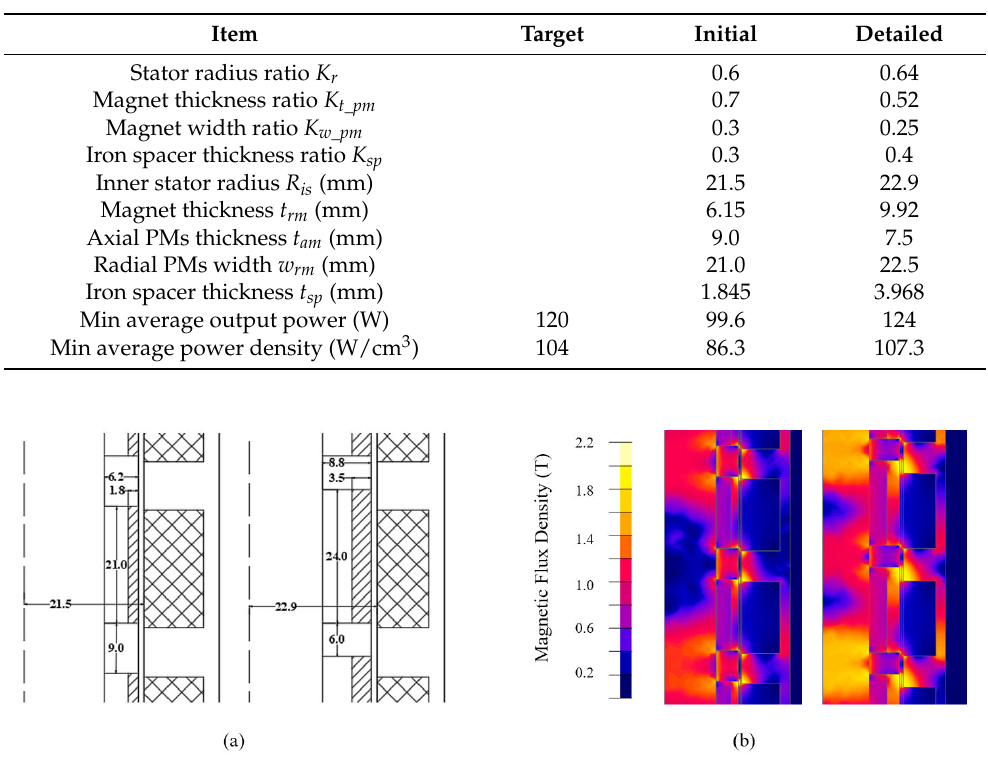
Figure 7. Geometric dimensions ( a ) and the flux distribution at t = 0 s of initial model ( left ) and the detailed model ( right ) ( b ).